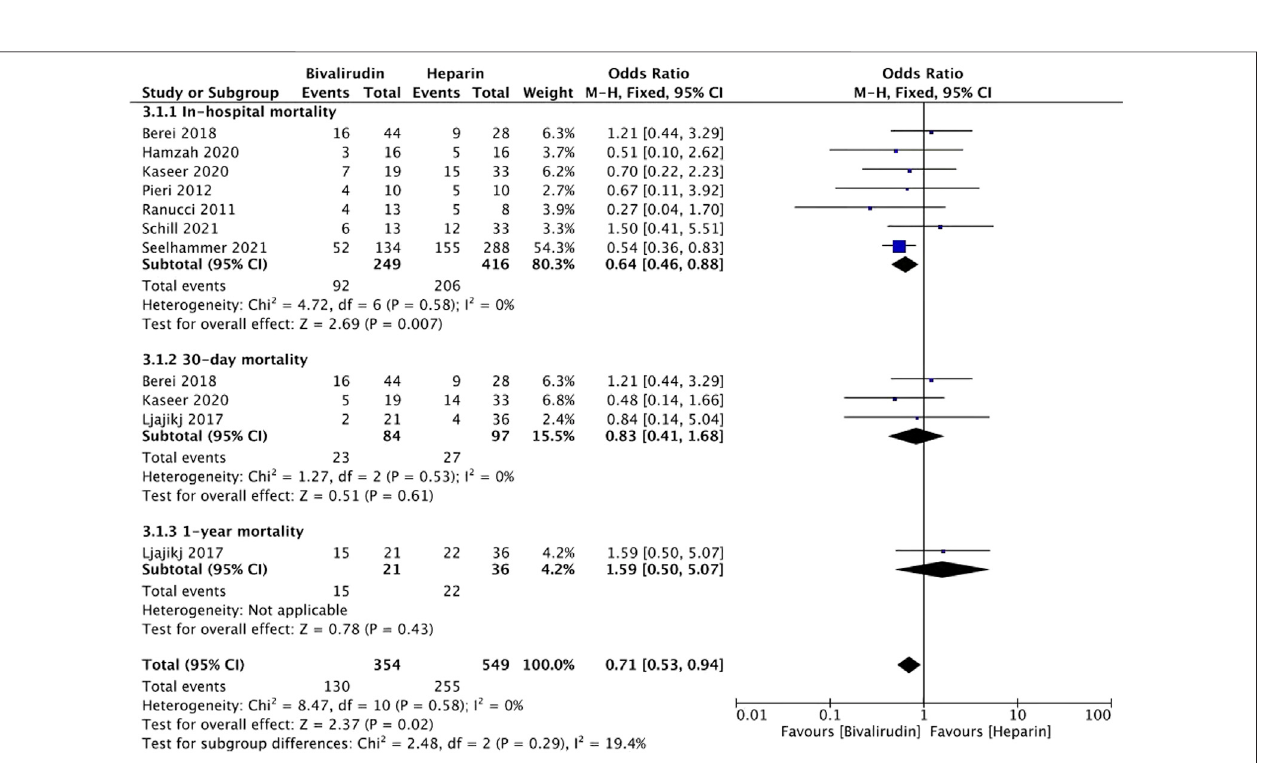
Frontiers in Pharmacology |